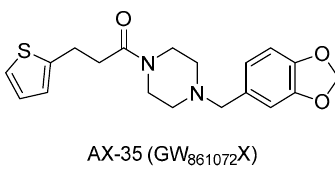
Figure 11. The chemical structure of AX-35.